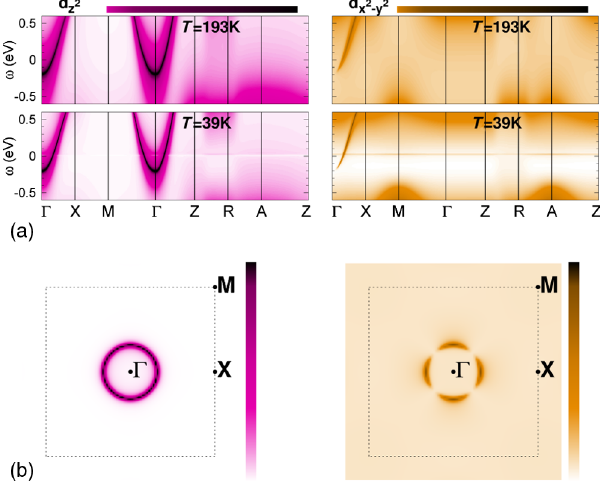
FIG. 3. Orbitals weights (i.e., “ fat-band ” picture) for Ni- d (left) and Ni- d (right) character in the k -resolved DFT þ x 2 − y 2 sicDMFT spectrum of NdNiO 2 . (a) Along high-symmetry lines in the Brillouin zone at T ¼ 193 K and T ¼ 39 K. (b) On the Fermi 0 plane at T ¼ 193 K. Note that the Ni- d surface in the k z ¼ color-scale maximum is 30 times larger than the Ni- d